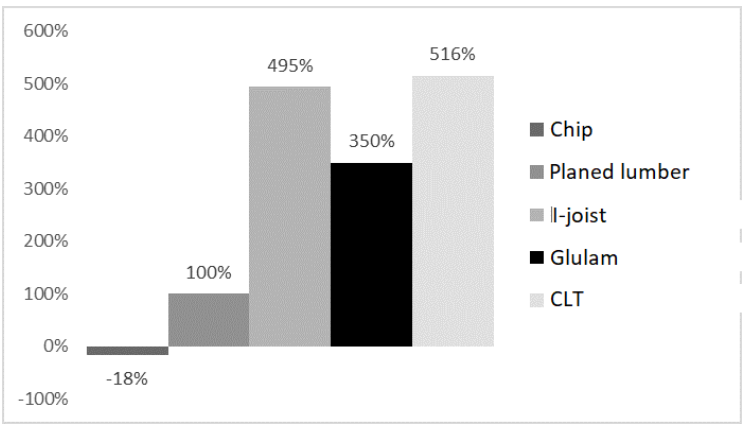
Figure 6: Relative profitability of the main products of the